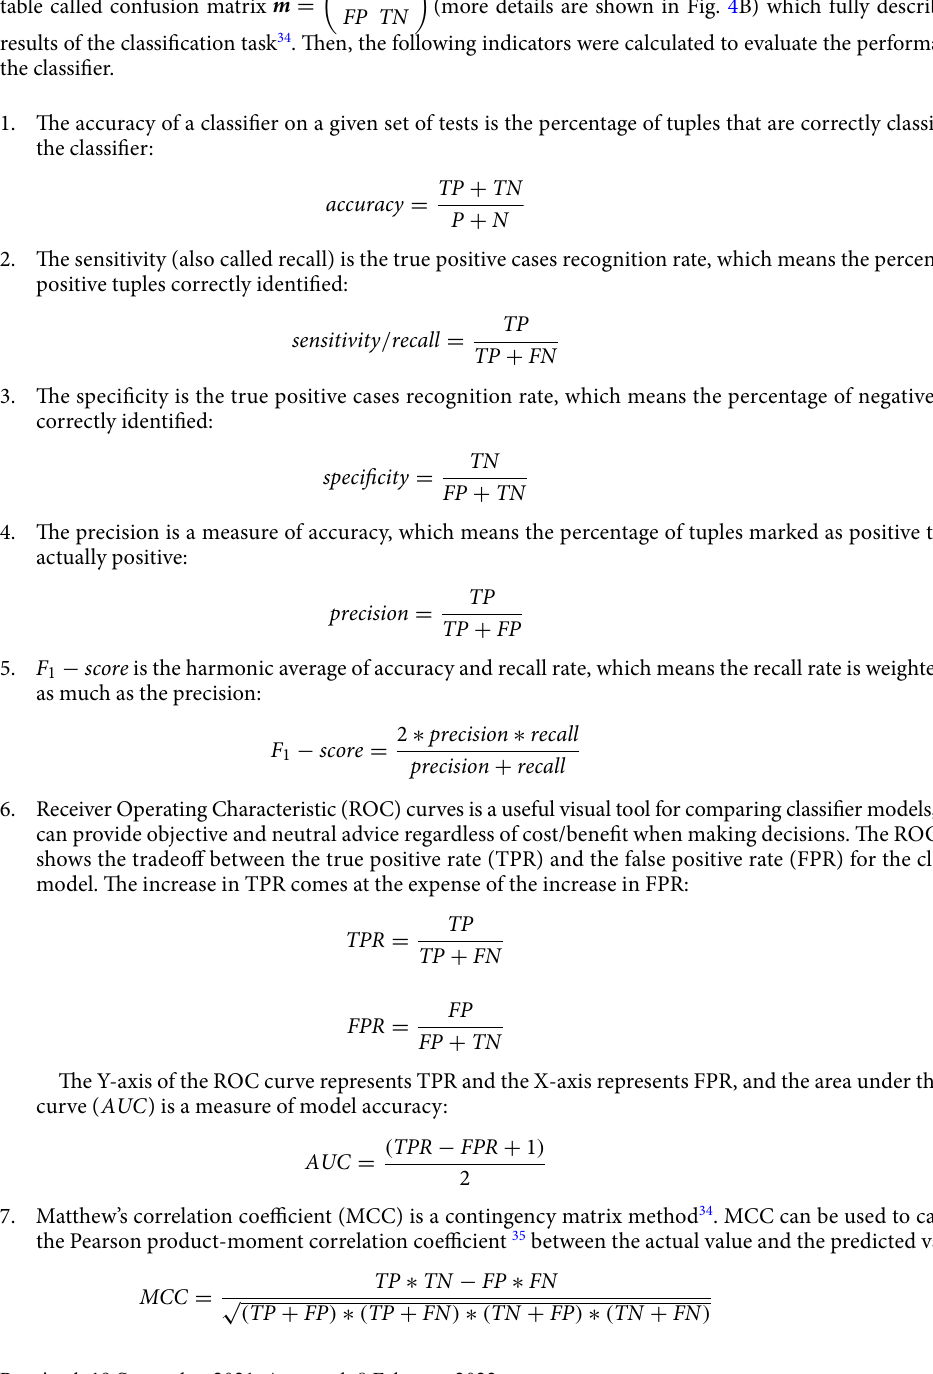
(cid:30) (cid:31) TP FN (more details are shown in Fig. 4B) which fully describes the FP TN =